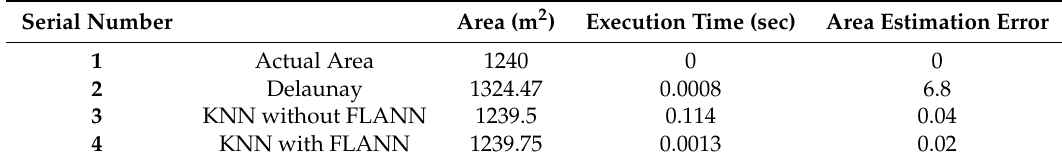
Table 1. Regular Shape 1.